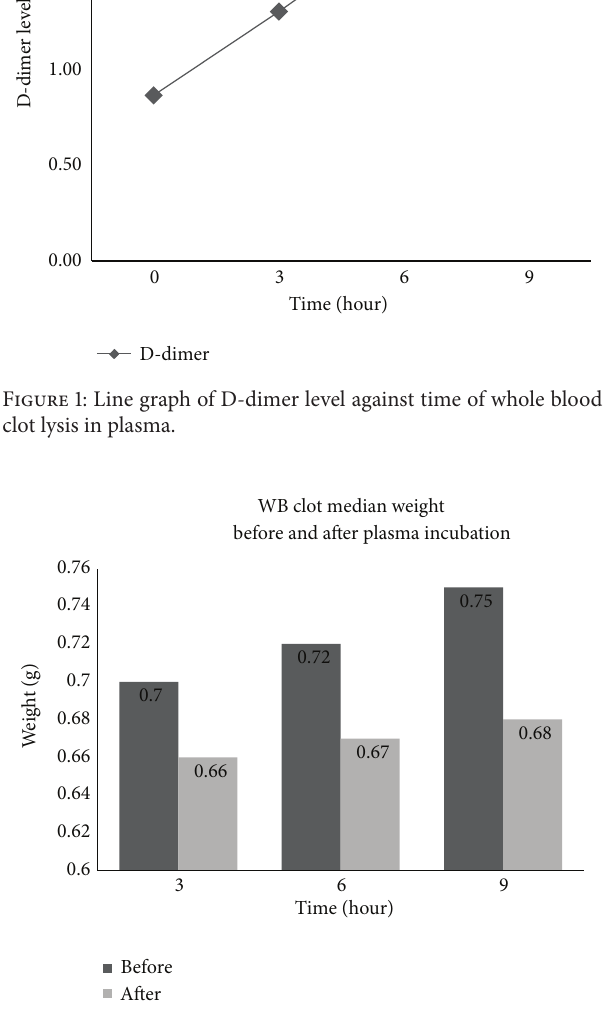
Figure 2: The difference in clot median weight between before and after pool PPP incubation.